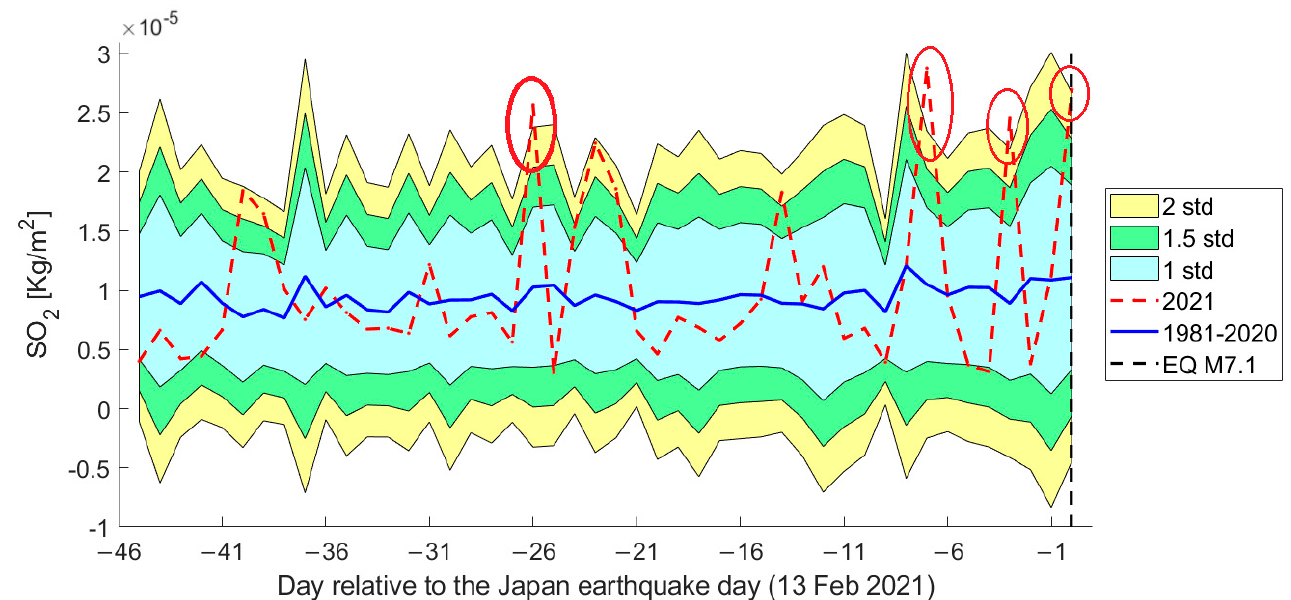
Figure 13. Atmospheric analysis of sulphur dioxide (SO 2 ) concentration in the 45 days before the Mw = 7.1 Japan 13 February 2021 earthquake in a square area of 3° size centred on the epicentre. For the estimation of the background values, the year 2001 was excluded due to its abnormal values. We highlight the anomalies with red circles, where a bold red circle means a significant and more robust anomaly.